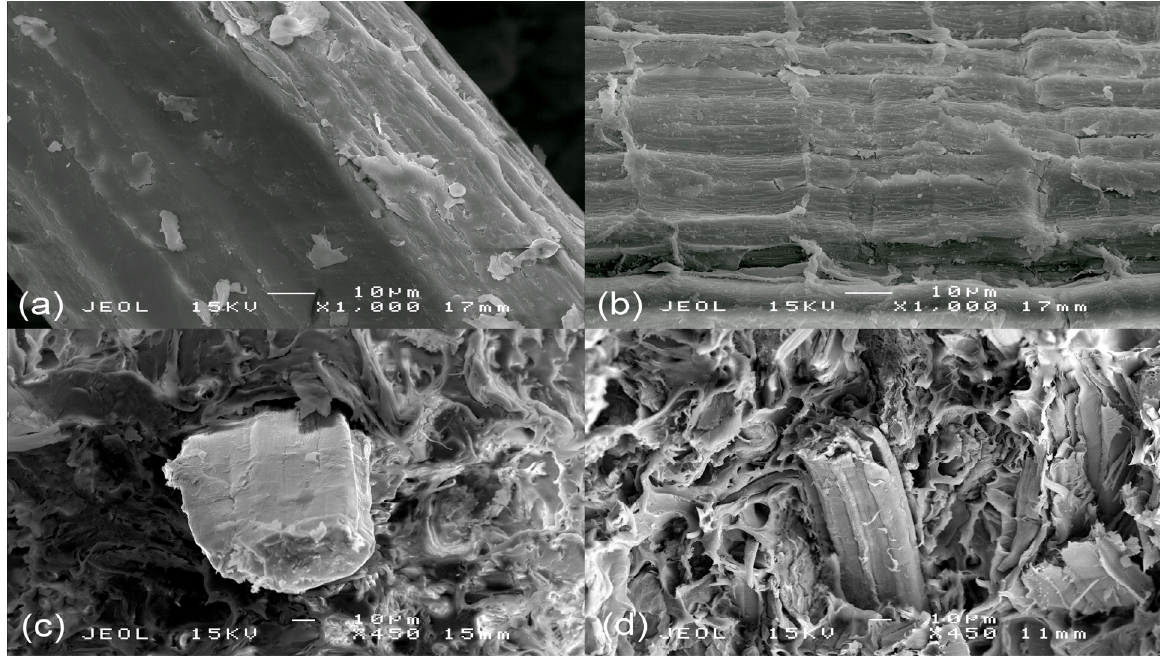
Figure 10. SEM images of ( a ) untreated fiber, ( b ) treated fiber ( c ) UBC composite ( d ) BC